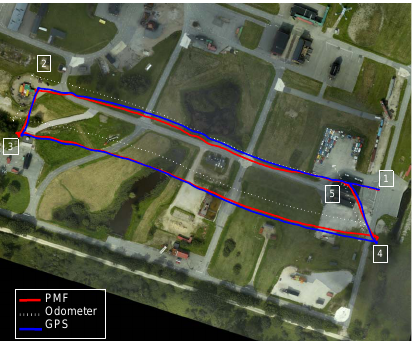
Figure 8: The figure displays the comparison between the flight path computed with the point-mass filter (red), the odometry alone (dashed white) and the GPS reference (blue).